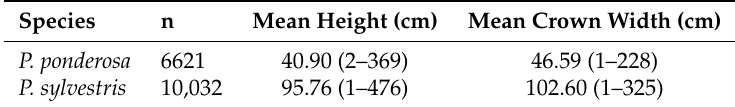
Table 3. Summary of the field data collected and used in the independent validation dataset. Values in brackets show the range of the measured tree heights and crown